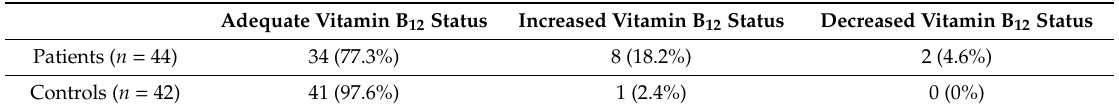
Table 2. Combined vitamin B12 index in GSD patients and controls.